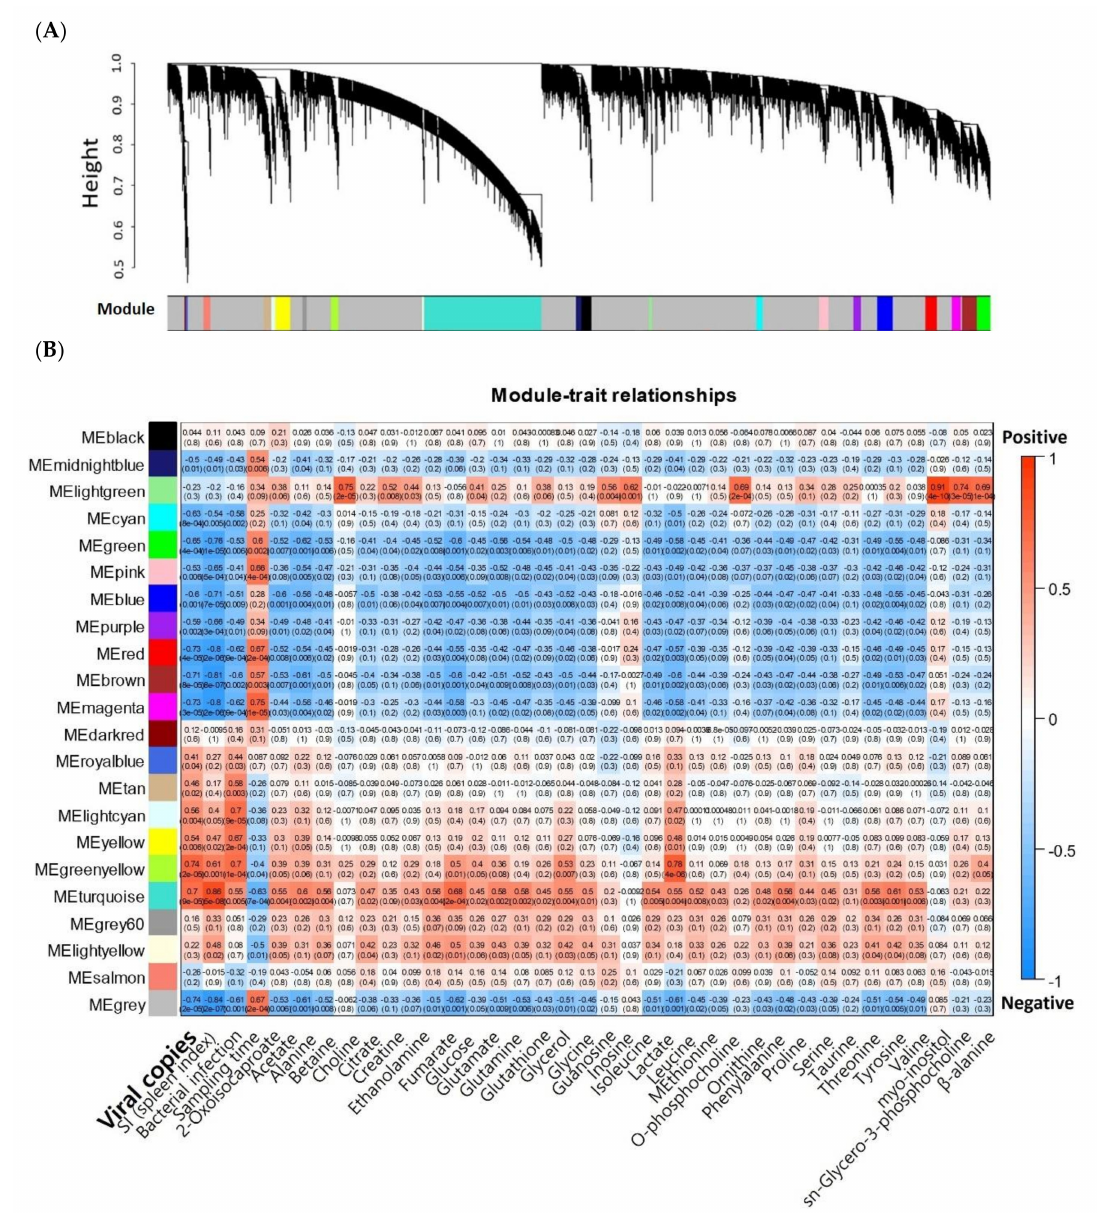
Figure 1. ( A ) Gene dendrogram and 22 di ff erent colors for modules obtained in this study. Dendrogram was calculated by average linkage hierarchical clustering. Module colors were determined by cutreeHybrid. ( B ) Module-trait associations. Correlations between module eigengenes (MEs, y -axis) and clinical traits ( x -axis) including viral loads, spleen index (SI), and relative concentration of several metabolites detected by NMR were calculated. Each block represents both Pearson’s correlation coe ffi cient and p -value (in